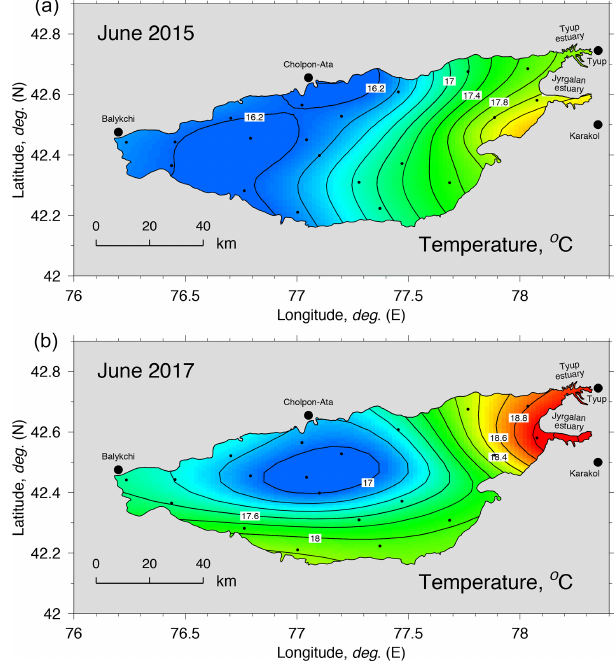
Figure 7. Distribution of lake surface temperature observed in June 2015 (a) and June 2017 (b) , based on data from hydrographic stations indicated by